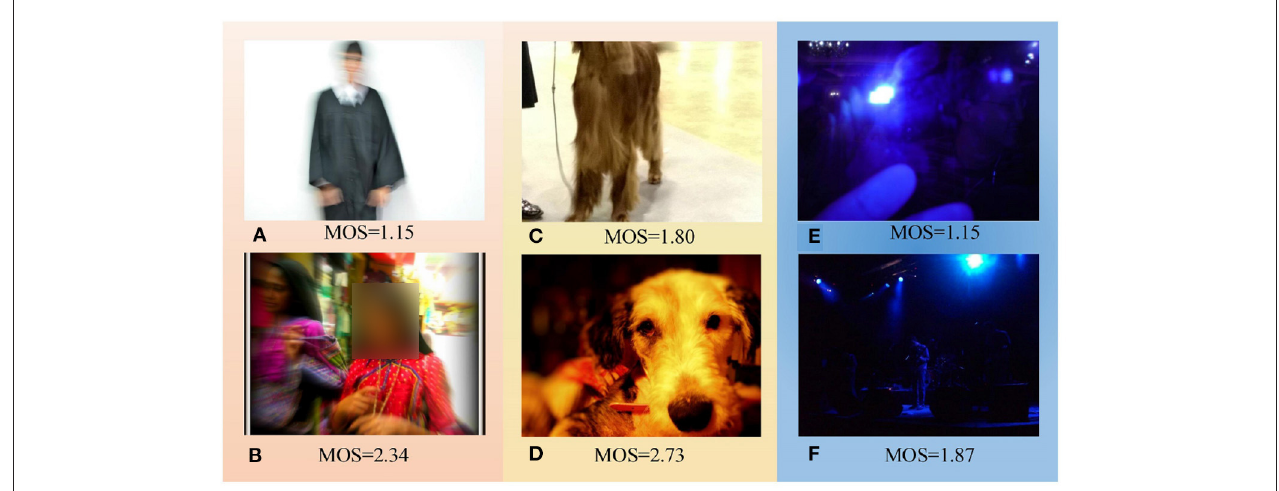
FIGURE 1 | Relation between intelligibility and image quality. (A–F) Compared to images in the first row, images in the second row have higher intelligibility and accordingly higher mean opinion score (MOS). Images are from the KonIQ-10k (Hosu et al., 2020) dataset. The range of MOS is [1,5], and higher MOS means better